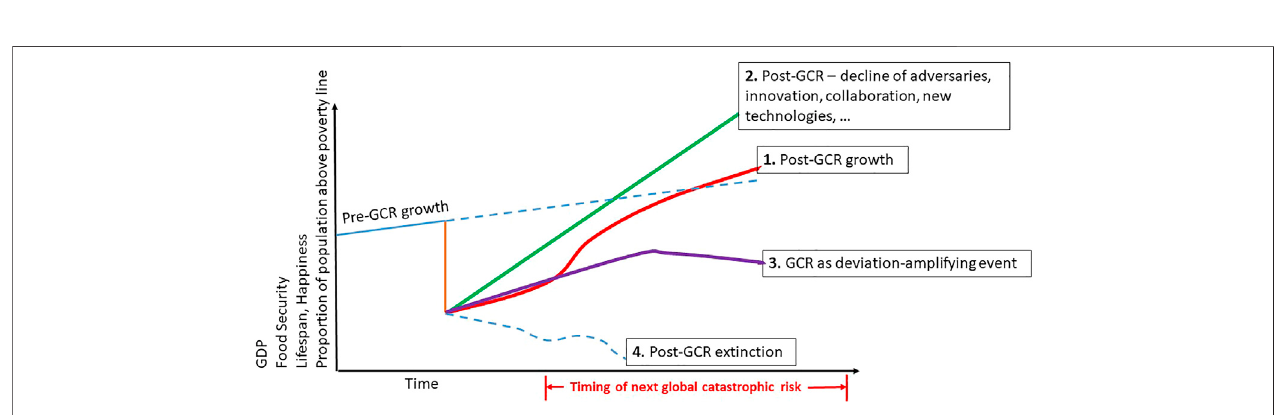
FIGURE 6 | Four possible futures following the occurrence of a global catastrophic risk(based on ideas in Brunsdon et al. (2013), Ratti (2017), Baum et al. (2019)). While the timing of the next global catastrophic risk is uncertain, it is quite likely to occur before recovery from the most recent one is complete.